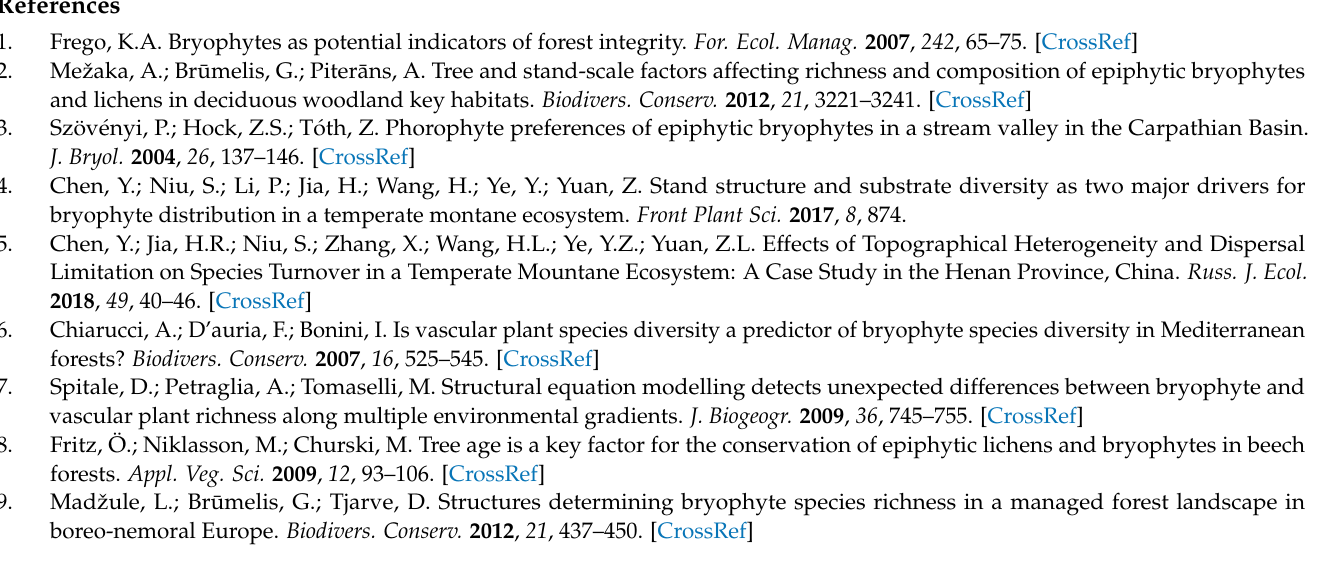
Table S3: Species abundance of bryophytes by species of woody plants; Table S4: Woody plant composition and abbreviations; Table S5: Bryophyte species composition and abbreviations. Table S6: Rare, common, or dominant species of epiphytic bryophyte in the